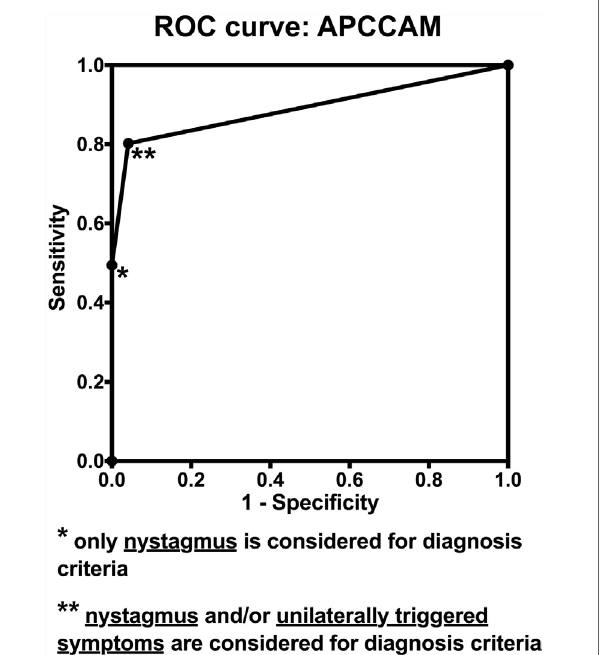
FigUre 5 | rOc curves for the aPccaM .